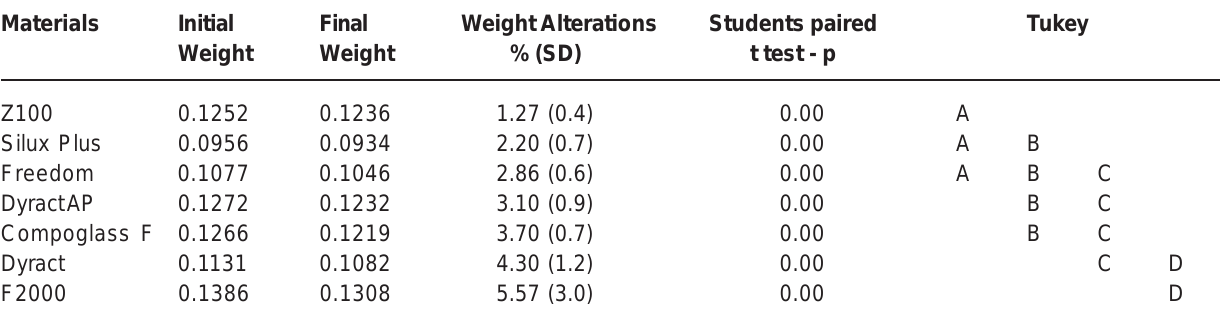
n=12; p<0.05; Different letters indicate statistical differences.